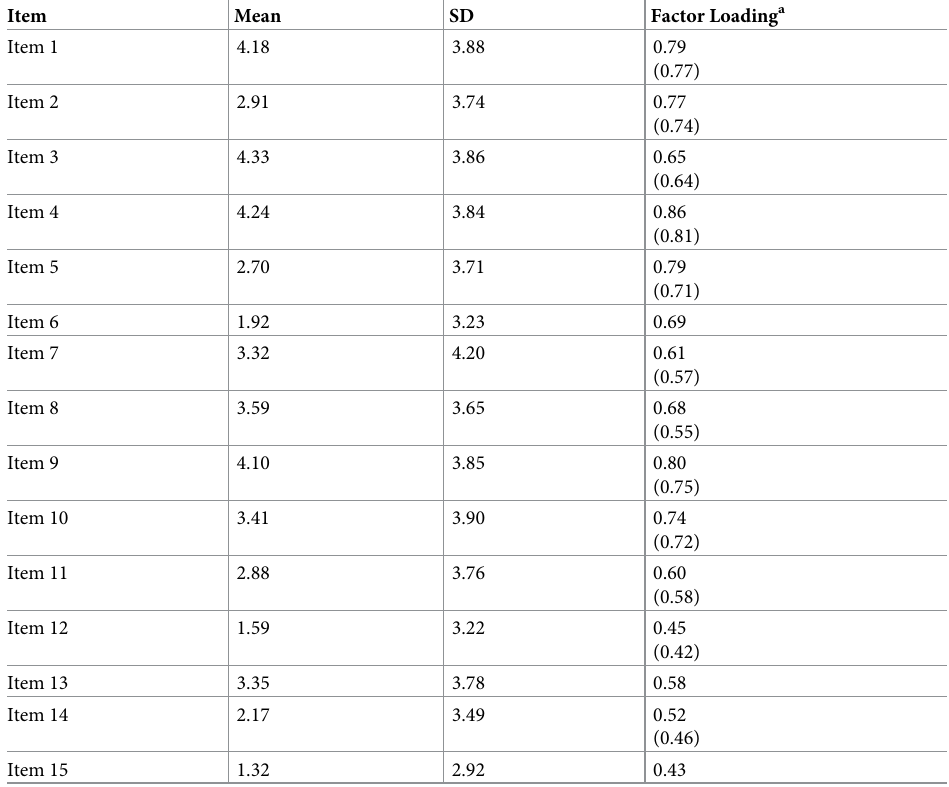
Table 1. Item descriptive statistics and factor loadings for the